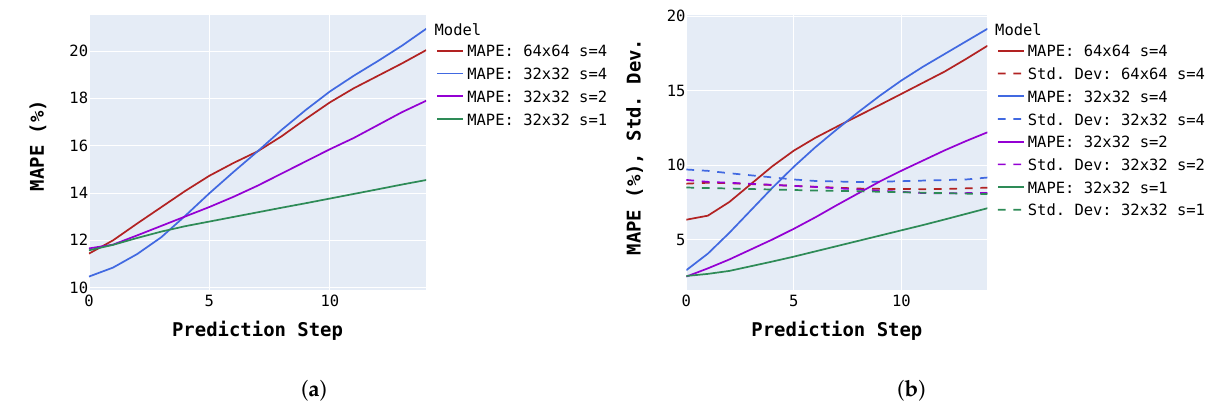
Figure 7. Mean absolute percentage error across all the data points consisting of two years in the test set (GMM) for ( a ) models without MCMC sampling, and ( b ) models with MCMC sampling. MAPE and standard deviation are averaged over all the coordinates of the pasture, and the prediction step for different models. We observe that, as s increases, the errors increase over the prediction horizon. s = 4,2,1 effectively correlate to 60, 30, and 15 day prediction